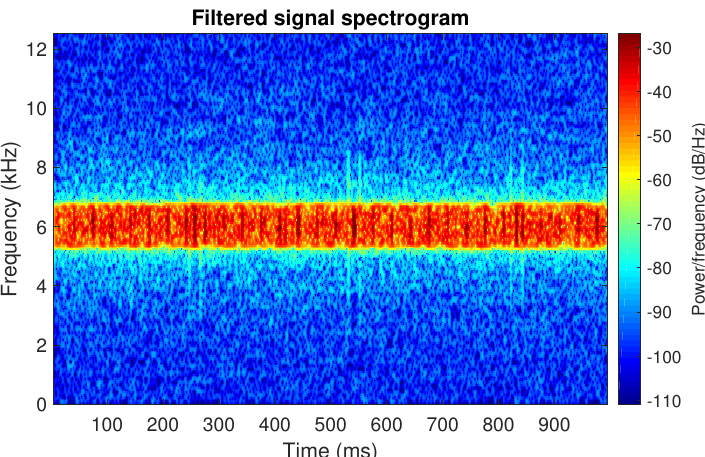
Figure 37. Spectrogram of filtered signal s 4 by Spearman